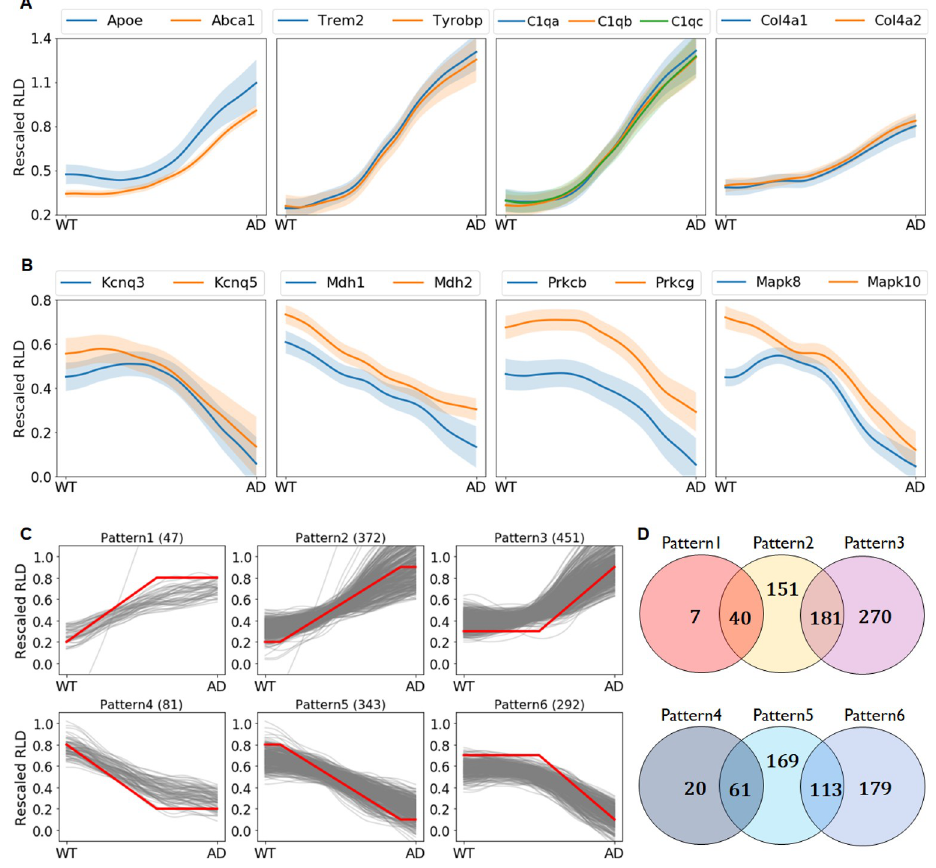
Fig 3. Transition curves of gene expression levels. (A-B) Transition curves of selected 17 genes from 7M WT to 7M AD: some up- and downregulated genes, which are known to be highly related or have similar names, were selected from pathways such as cholesterol metabolism (Apoe, Abca1), microglia pathogen phagocytosis pathway (Trem2, Tyrobp), complement and coagulation cascades (C1qa, C1qb, C1qc), focal adhesion (Col4a1, Col4a2), cholinergic synapse (Kcnq3, Kcnq5, Prkcb, Prkcg), TCA cycle (Mdh1, Mdh2), and dopaminergic synapse (Mapk8, Mapk10); (C) Each curve belongs to a pattern when r (the correlation coefficient with the predefined red colored curve patterns which we proposed) is higher than 0.95 or when the maximum r is above 0.90; (D) Venn diagrams for the number of transition curves belonging to each pattern. The total number of curves in the six patterns is 1,191 (649 upregulated, 542 downregulated). Among the 1,208 DEGs, seventeen genes could not be classified into the six patterns. coagulation cascades (mmu04610, FDR = 7.0E-4), NF-kappa B signaling pathway (mmu04064, FDR = 9.1E-3), cytokine-cytokine receptor interaction (mmu04060, FDR = 0.039), etc. in 25 selected UP pathways. We observed many inflammatory GOBP path- ways with named leukocytes (S2 Table) not shown in the 25 UP pathways. The next noticeable pathways are associated with integrin-associated pathways: the integrin-mediated signaling pathway (GO:0007229, FDR = 3.6E-16), cell adhesion mediated by integrin (GO:0033627, FDR = 7.5E-8), and focal adhesion (WP85, 1.0E-3), which receive attention in AD pathogene- sis [25]. The dominant pathways with downregulated genes are related to vesicles and neuro- transmitters: synaptic vesicle cycle (mmu04721, FDR = 7.3E-5; GO:0099504, FDR = 2.1E-8), neurotransmitter transport (GO:0006836, FDR = 2.4E-8), exocytosis (GO:0006887, FDR = 7.4E-8), and vesicle-mediated transport in synapses (GO:0099003, FDR = 4.1E-10). The next noticeable pathways with downregulated genes are associated with specific synapses: GABAer- gic synapse (mmu04727, FDR = 1.3E-3), dopaminergic synapse (mmu04728, FDR = 1.8E-3),